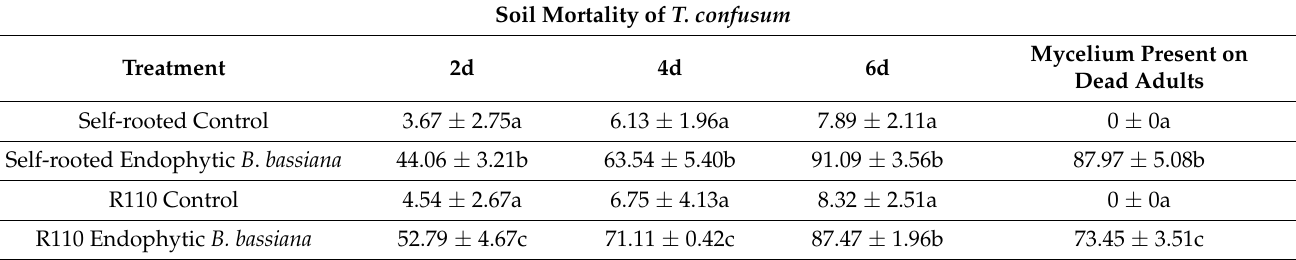
Table 3. T. confusum bait used to trap B. bassiana ; mean percentage of mortality on vine soil and mean percentage of mycelium present on